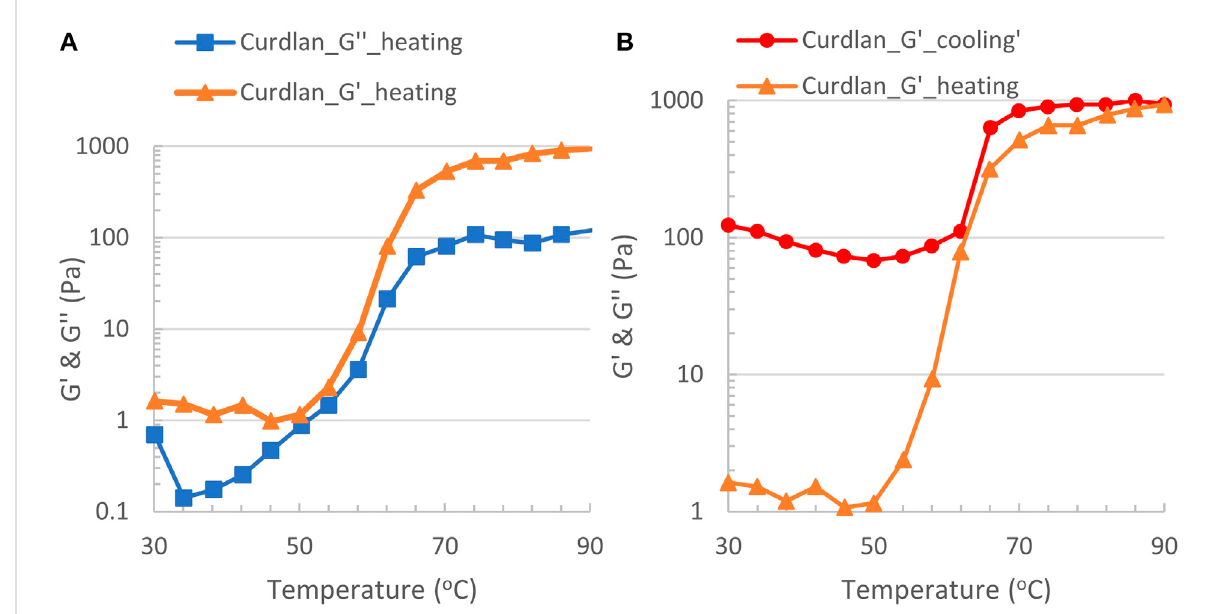
FIGURE 19 (A) Storage moduli G ′ and los moduli G ″ of 6 wt% curdlan suspension in water during heating, and (B) G ′ during heating and cooling (based on Panthi et al.,